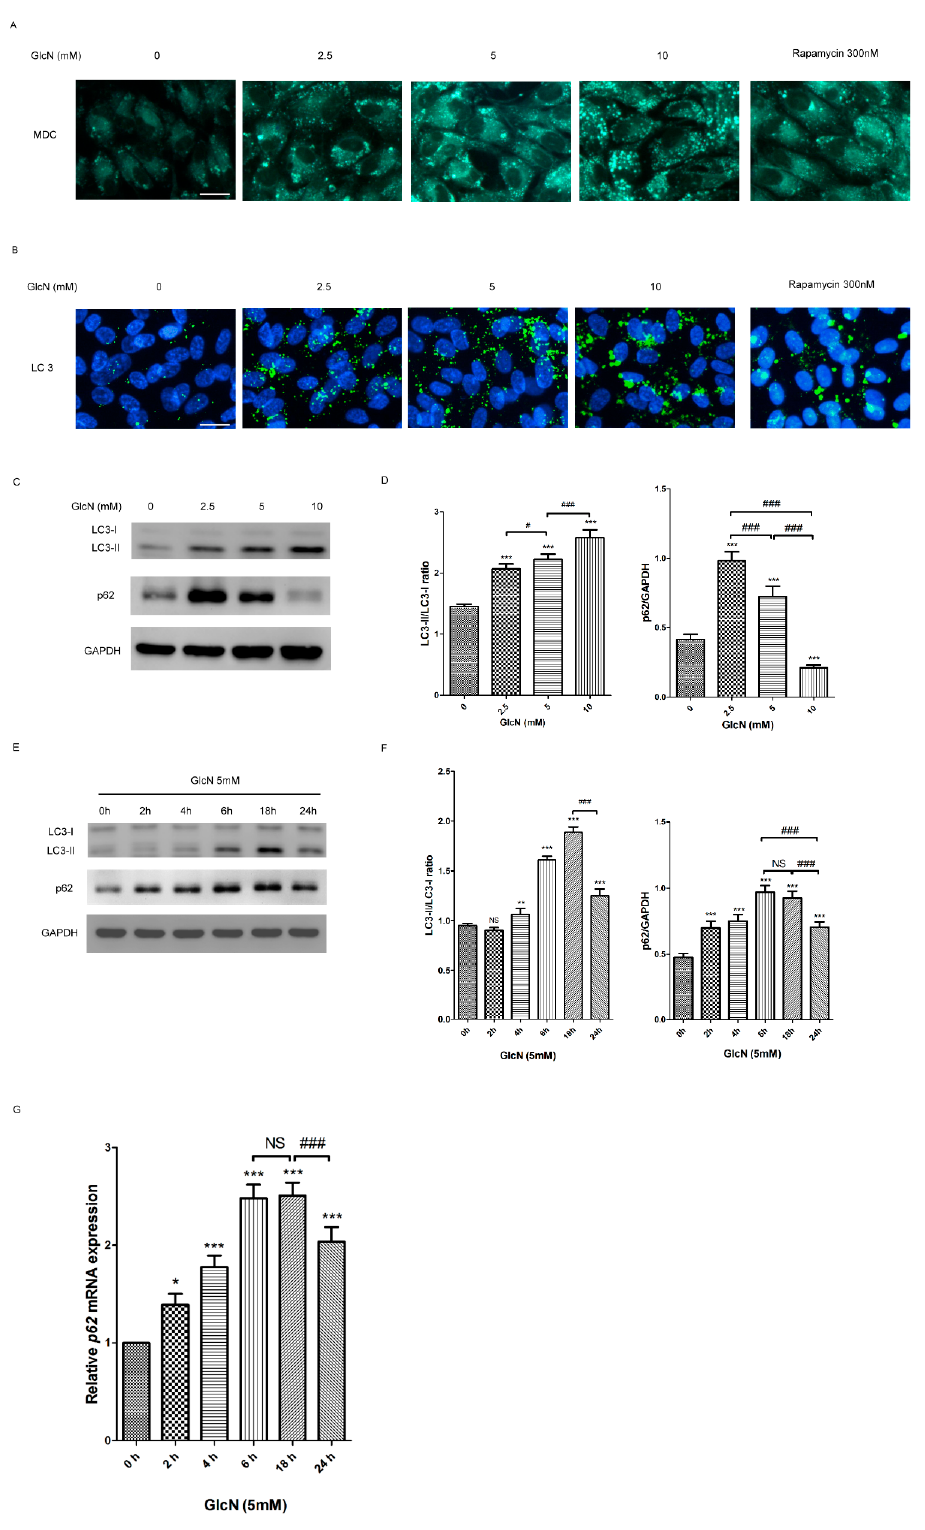
Figure 2. Glucosamine (GlcN) increases autophagosome and autophagic markers in ARPE-19 cells. ( A ) The number of monodansylcadaverine (MDC)-labeled vacuoles increased by either GlcN or rapamycin (Rapa) treatment in ARPE-19 cells. Cells were treated with or without 2.5 mM GlcN, 5 mM GlcN, 10 mM GlcN, or 300 nM rapamycin (Rapa) for 18 h and then stained with MDC. Rapa treatment was used as a positive control. MDC-labeled vacuoles were examined by fluorescence microscopy. Magnification, ×